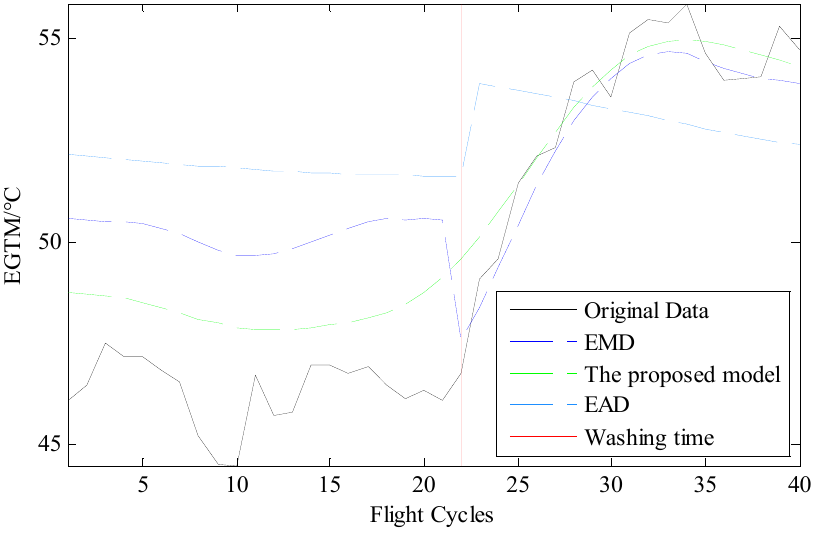
Figure 15. Comparison of noise reduction effects of three noise reduction models. The red vertical line in Figure 15 represents the time of washing the aeroengine. Due